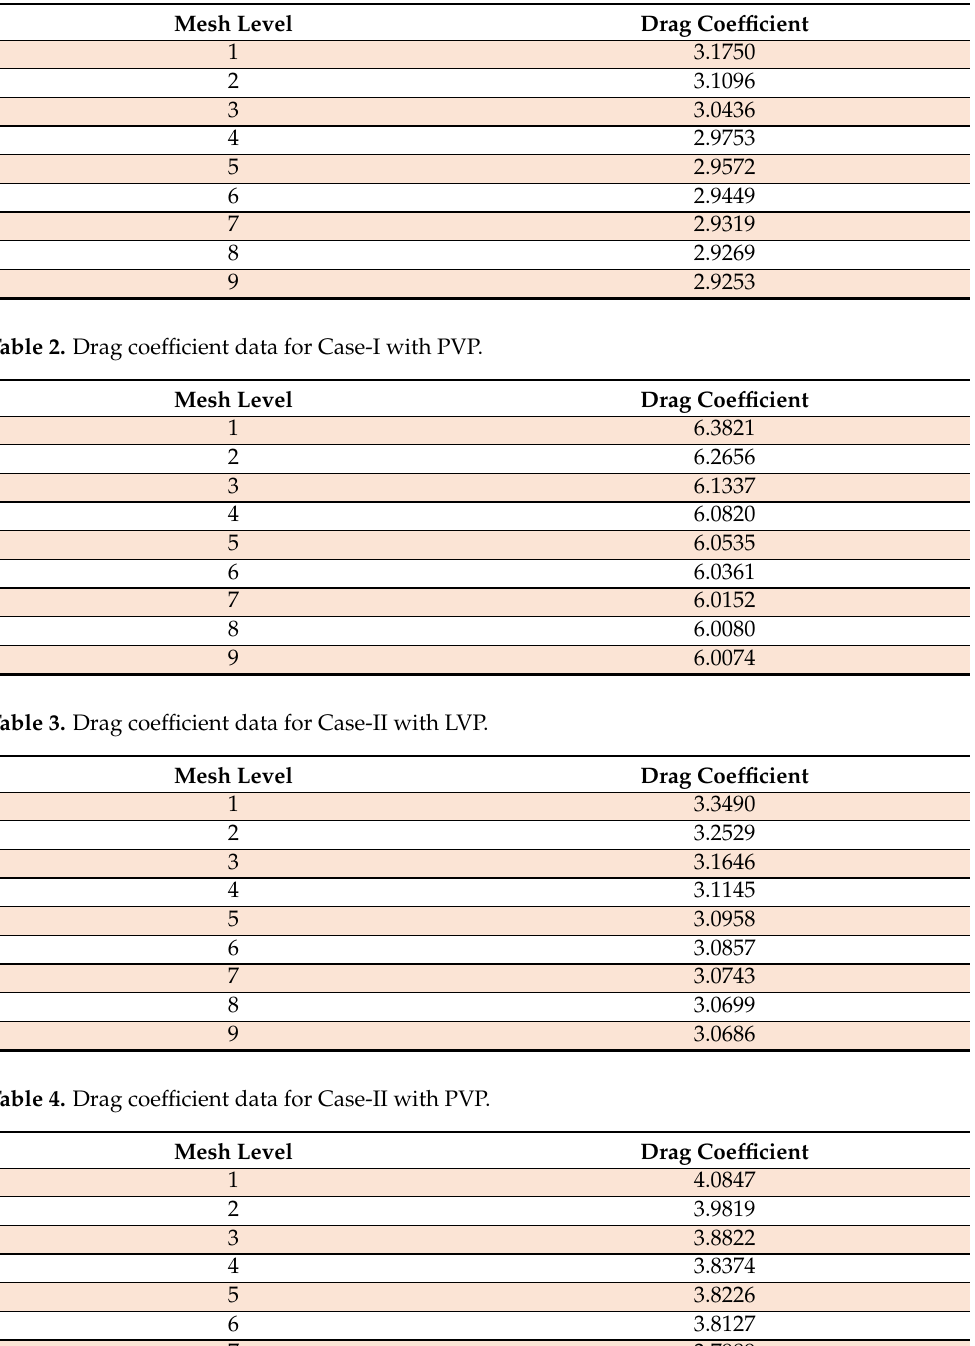
Table 1. Drag coefficient data for Case-I with LVP.